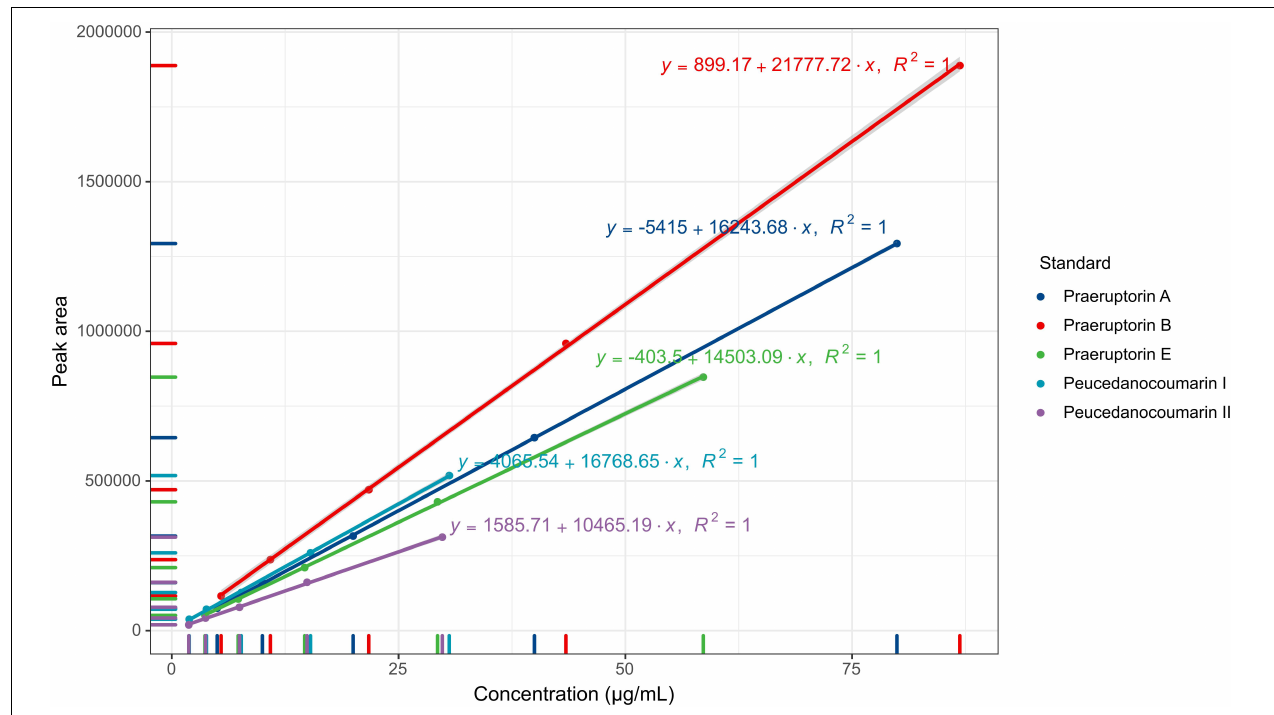
FIGURE 2 | The standard curve and equations of the five coumarin